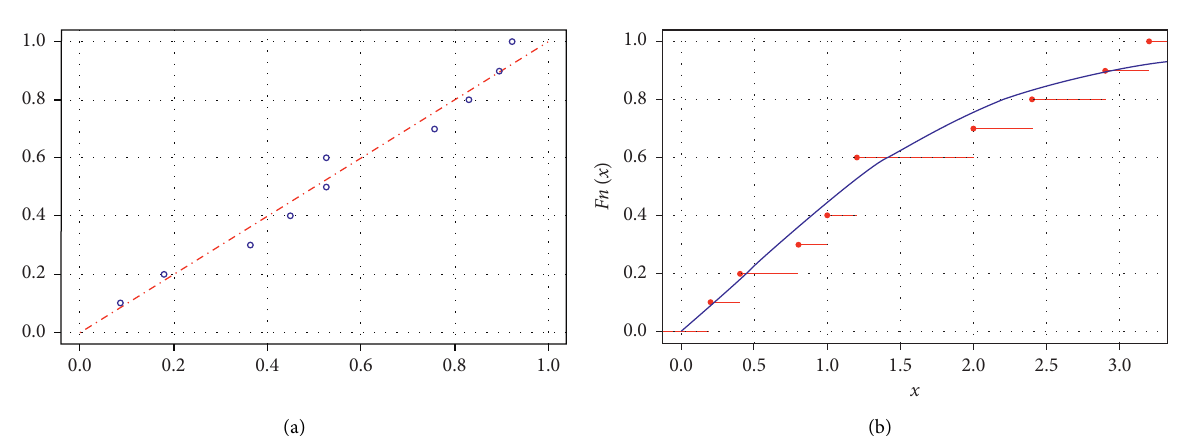
Figure 1: QQ plot and CDF of the real data set I on the EPL distribution. (a) QQ plot of sample vs theoretical distribution; alpha � 1, beta � 1.1, and theta � 1. (b) CDF for sample and theoretical CDF.